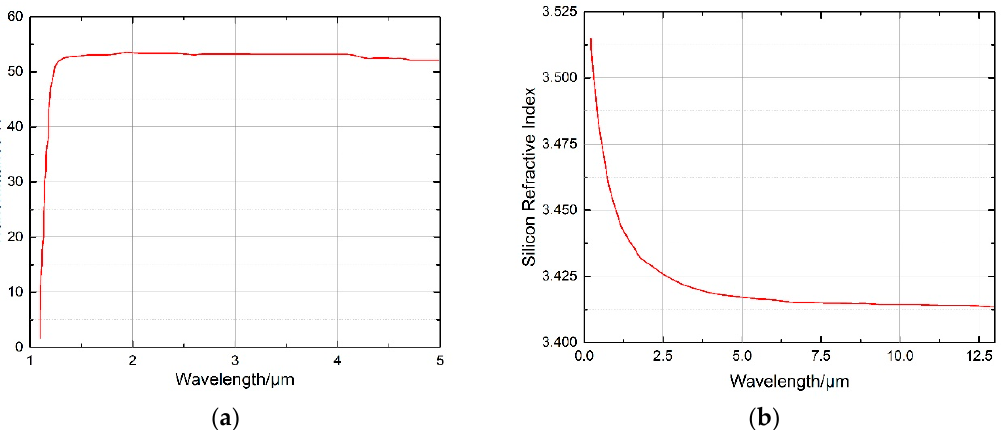
Figure 2. Optical properties of single crystal silicon ( a ) Refractive index; ( b ) transmittance of silicon in the mid-infrared.